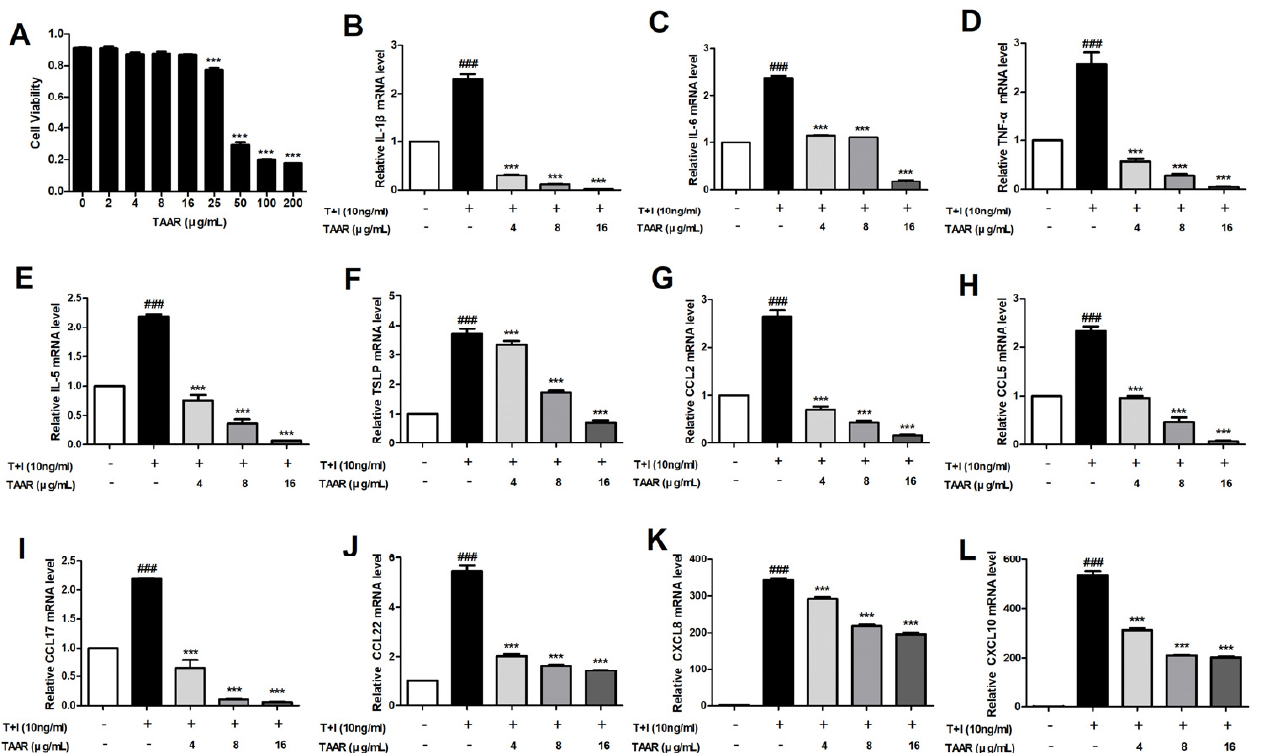
Figure 3. Effects of TAAR extract on the viability of and the inflammatory response in TNF- α /IFN- γ -induced HaCaT cells. ( A ) Cytotoxicity of TAAR extract. mRNA expression of ( B – F ) cytokines IL- 1 β , IL-6, TNF- α , IL-5, and TSLP and ( G – L ) chemokines CCL2, CCL5, CCL17, CCL22, CXCL8, CXCL10. All values are presented as the mean ± SEM of three experiments. Data were analyzed by Tukey’s post hoc test. ### p < 0.001 vs. no treatment group; * p < 0.05, ** p < 0.01, and *** p < 0.001 vs. TNF- α /IFN- γ treatment only group.